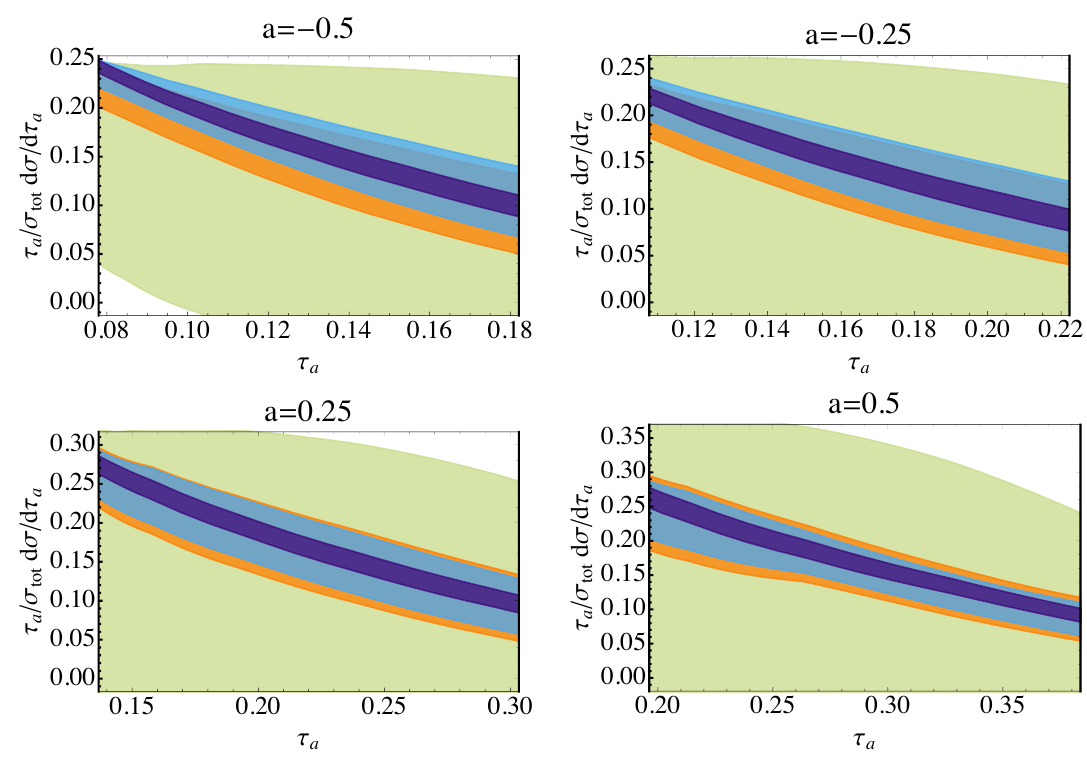
Figure 12 . Di(cid:11)erential angularity distributions for four values of a = Q = m Z in the central (cid:28) a region, resummed and matched to NLL (green), NLL 0 + NNLL+ ( (cid:11) s ) (blue), and NNLL 0 + O corresponding orders, and uncertainties estimated with the scan